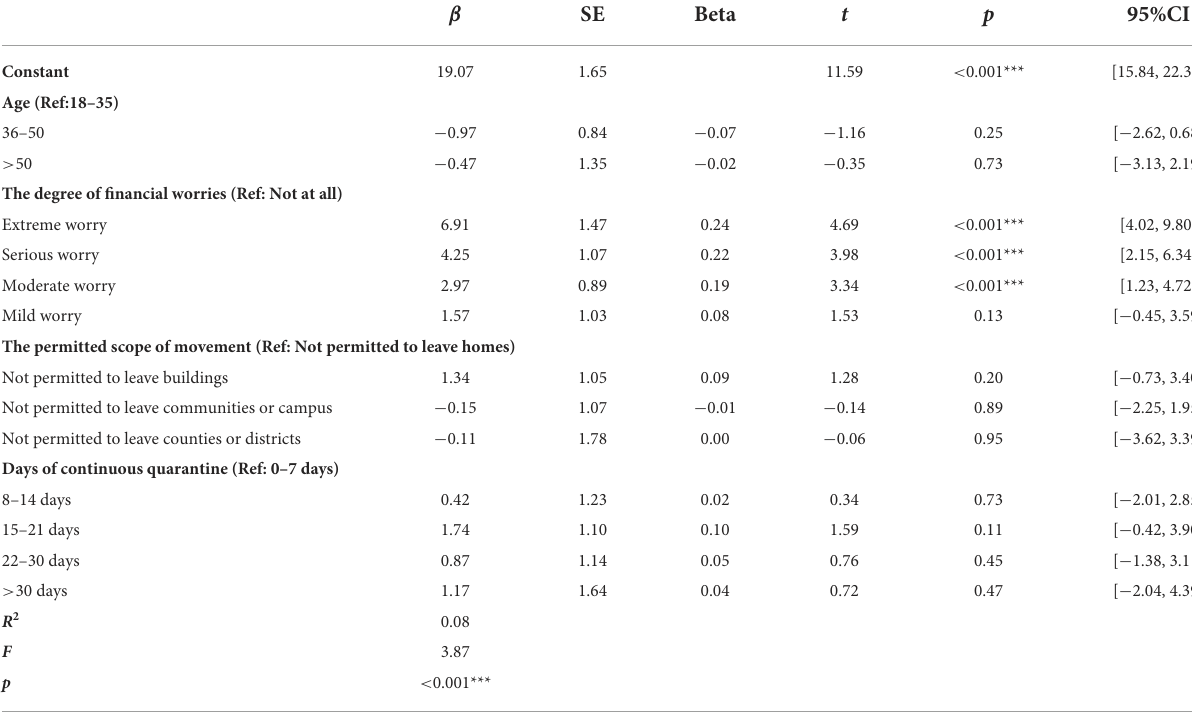
TABLE 5 Multiple linear regression analysis on physical